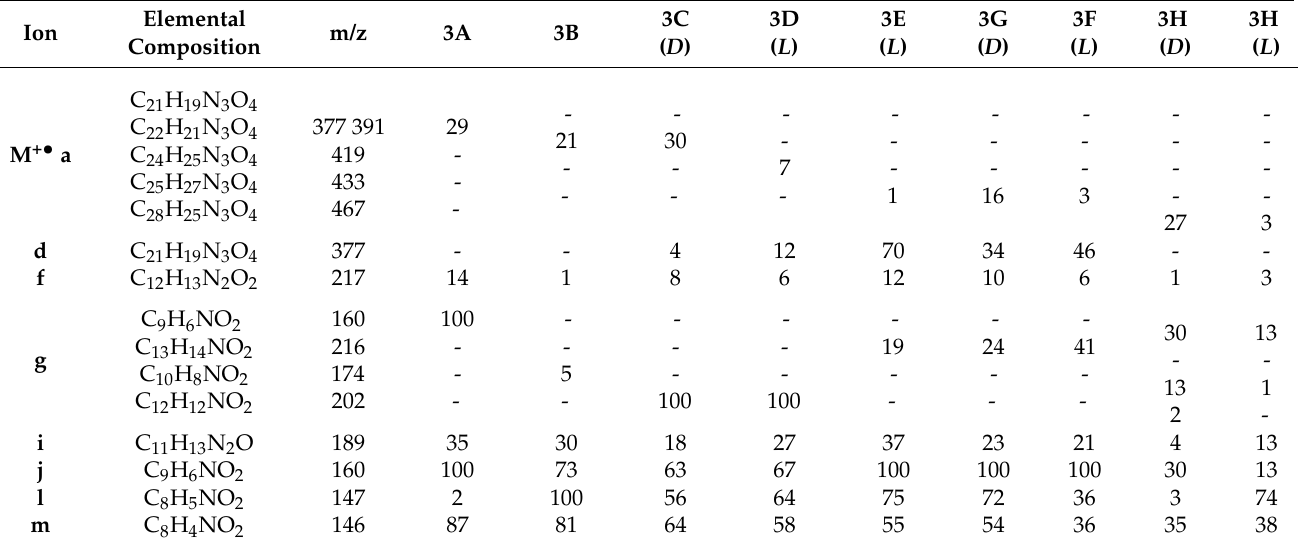
Table 1. Elemental compositions and relative abundances of the ions in the EI spectra of compounds 3A – 3H . Elemental Ion